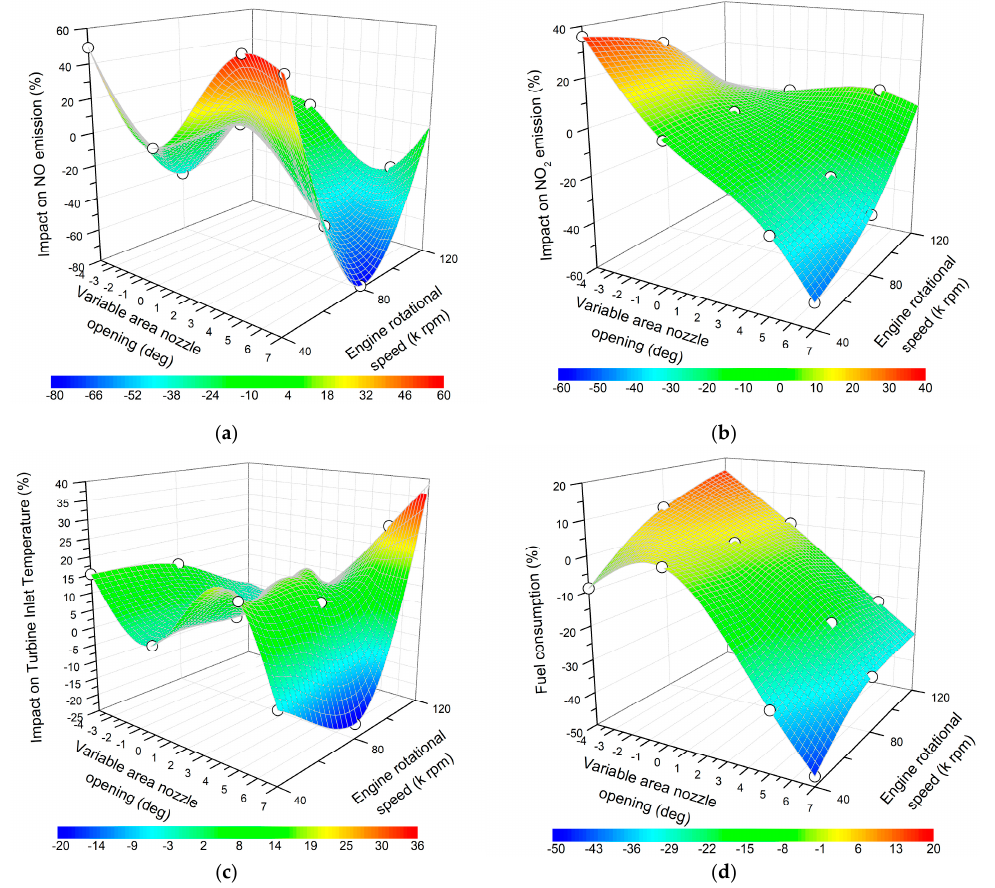
Figure 13. Turbine variable area nozzle impact on generation of: ( a ) nitrogen monoxide (NO); ( b ) nitrogen dioxide (NO 2 ); ( c ) turbine inlet temperature; ( d ) fuel consumption.